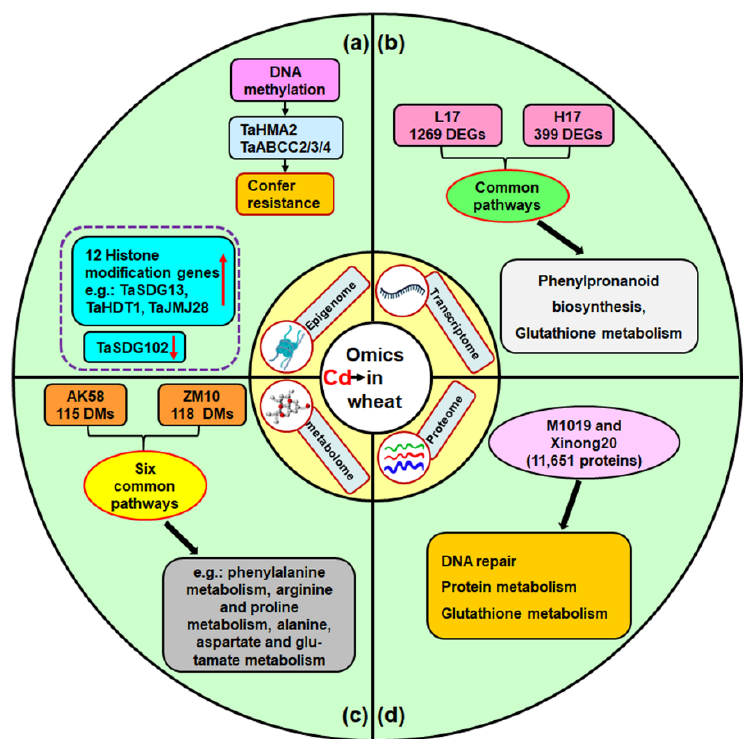
Figure 3. Omics uncovering Cd stress in wheat. Epigenetic response ( a ), transcriptome ( b ), proteome ( c ), and metabolome ( d ) revealing Cd stress in wheat. DEGs, differentially expressed genes; DMs, differential metabolites. Up red arrow represents upregulated, down red arrow represents down-regulated.